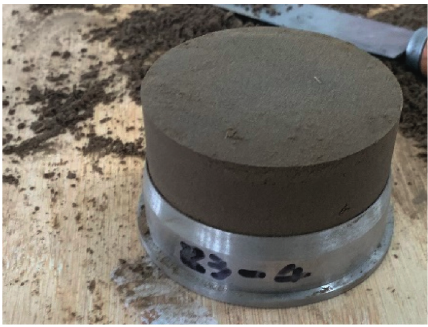
Figure 9: Ring cutter